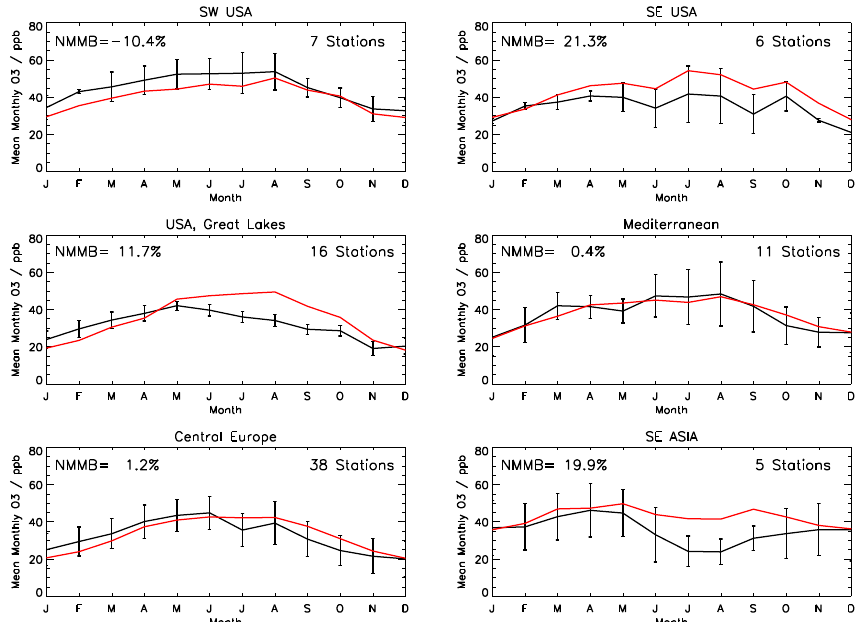
Fig. 3. Regionally-averaged monthly-mean surface ozone concentrations from monitoring stations (black line) and the TOMCAT model under the control scenario (red line) for the year 2000. The model results are the means for the model gridboxes where the stations are located with the model ozone concentration scaled from 30m (centre of surface gridbox) to 10m (measurement sample height). Error bars indicate 1 standard deviation on the monthly mean observations. The normalised model mean bias (NMMB) is indicated for each